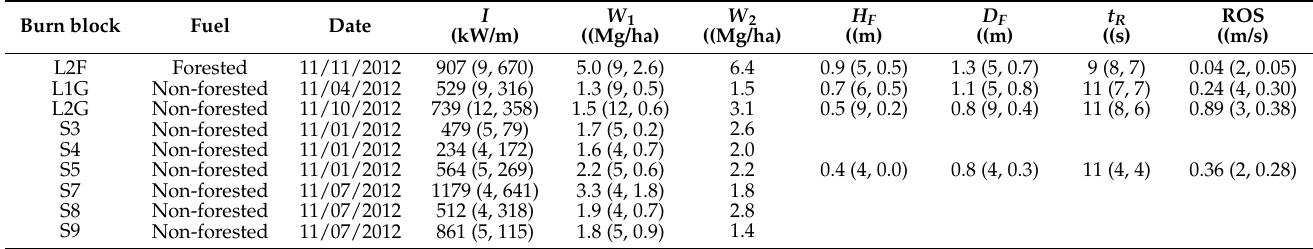
Table 1. Averaged characteristics of surface fires and flames in forested and non-forested burn blocks from the RxCADRE 2012 fires. Fireline intensity ( I ) and fuel consumption ( W 1 ) are inferred from nadir radiometer measurements using equations in Kremens et al. (2012, see Supplementary Material) while whole-block estimates of consumption ( W 2 ) are from Hudak et al. (2016). Estimates of flame height ( H F ), depth ( D F ), residence time ( t R ), and fire rate of spread (ROS) are from video analysis [19,36]. Sample sizes and standard deviations are provided (in parentheses) where